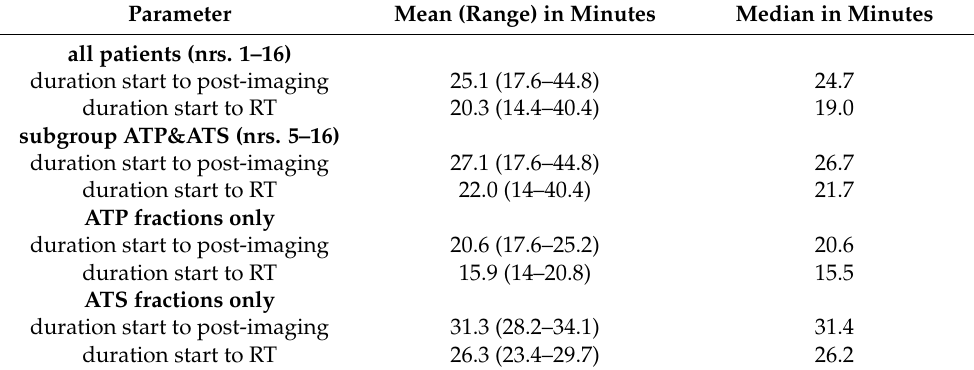
Table 3. Duration of the treatment process by